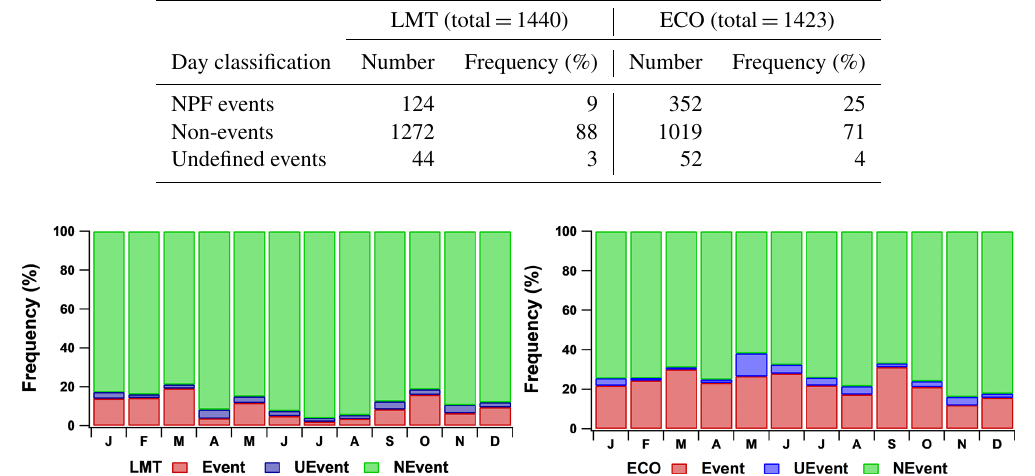
Figure 2. Monthly percentage of occurrence of events (red bars), undefined events (blue bars), and non-events (green bars) related to available measurement days at LMT and